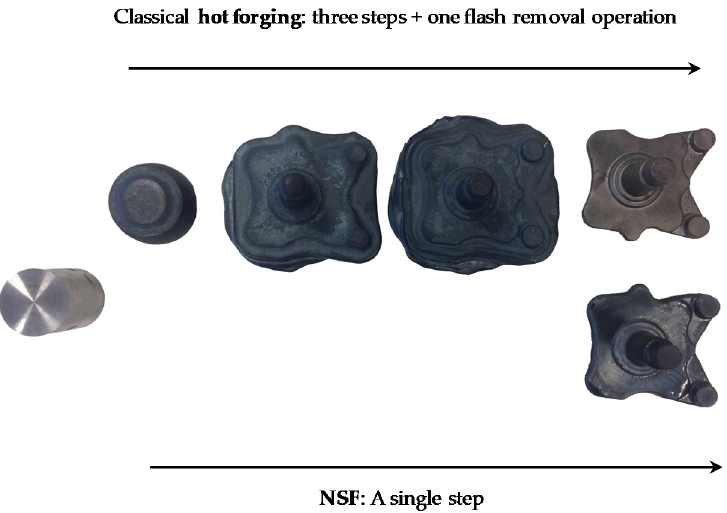
Figure 5. A comparison of the required forming steps to get the H spindle by hot forging and NSF. The case of the R spindle is similar. The number of forging steps is reduced from three to one and raw material consumption reduced by 20%. As shown in Table 8, forming loads are drastically reduced in both cases. The hot forging loads correspond to the second step, in which maximum peak loads are measured. Loads measured for the 44MnSiVS6 and EN 13262-ER7 are also in the same range (see Sections 3.3 and 3.4), but as they are not used in hot forging, they are not included in Table 8. Table 8. Comparison of forming steps, press capacity, peak forces, and raw material needed to manufacture the R and H spindles by hot forging and NSF.